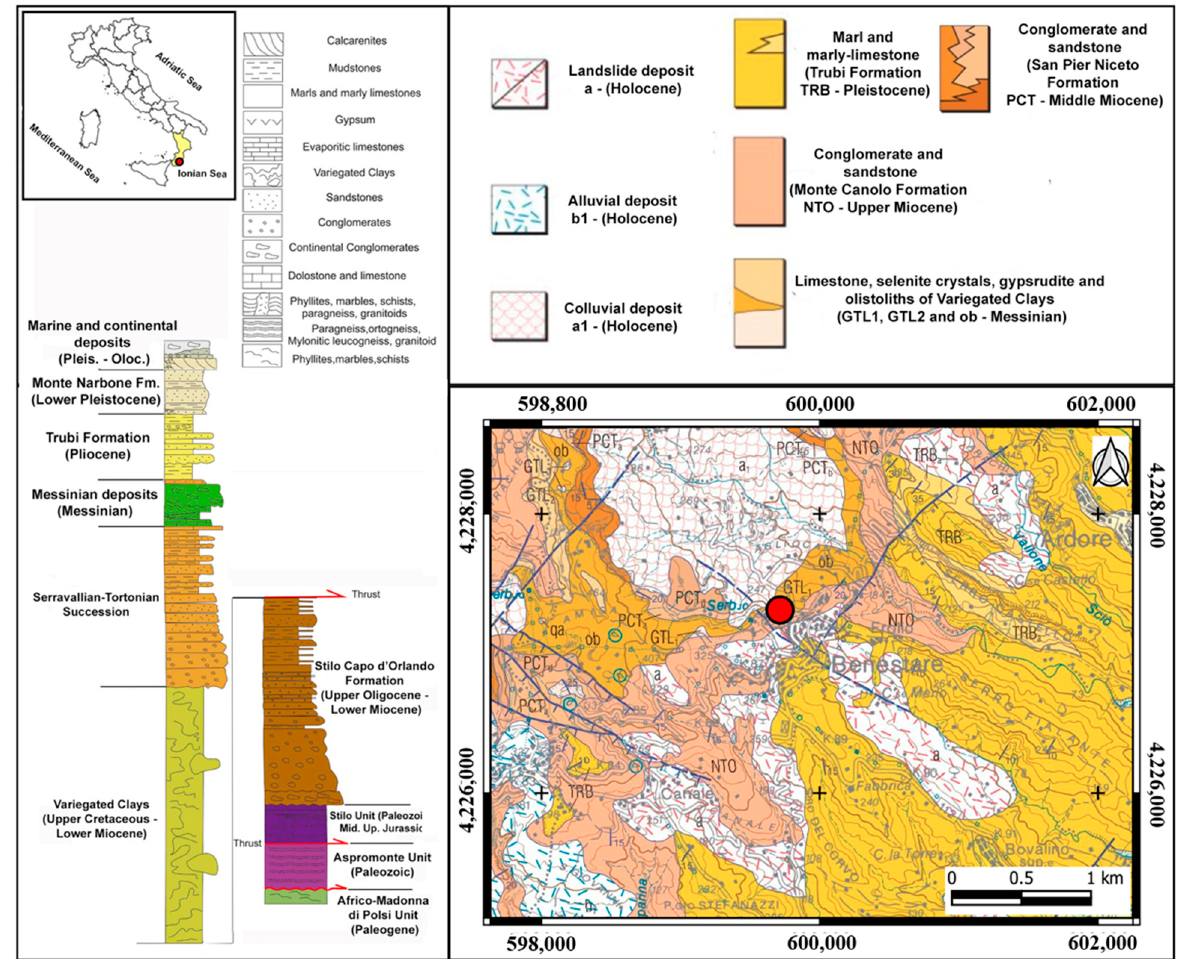
Figure 1. Local geological sketch map of the study area [73] and stratigraphy of the Ionian forearc basin (modified after Tripodi [62]). The abbreviation of the stratigraphic legend refers to [73]. Red circle indicates Benestare’s quarry.